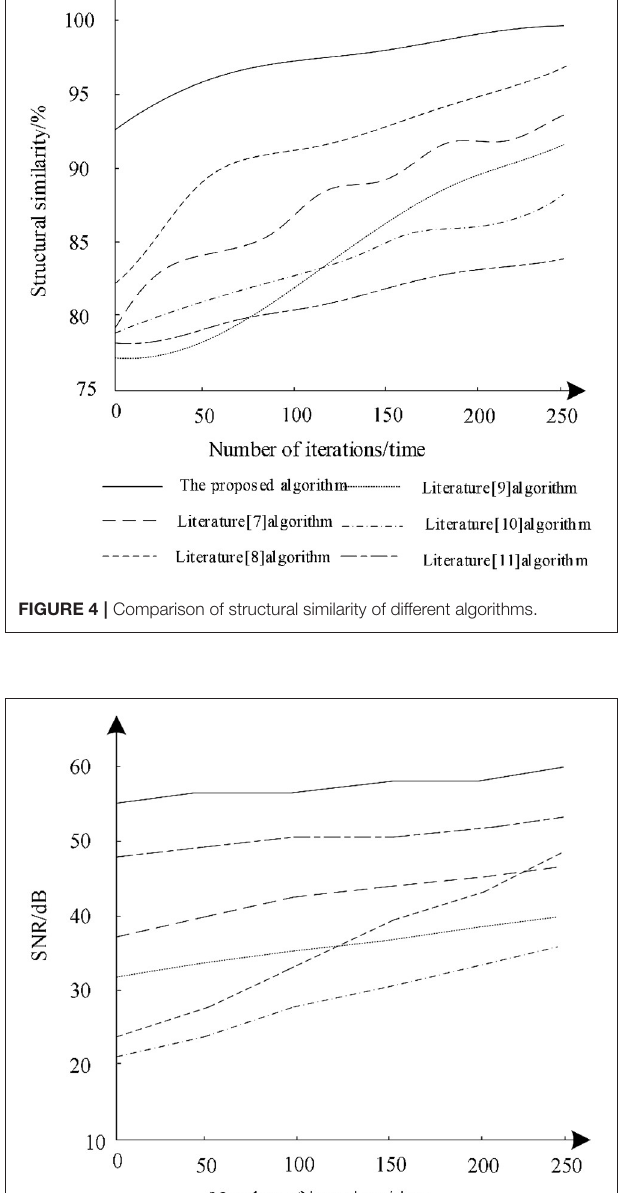
SNR is always maintained between 55 and 60 dB. Therefore, using proposed algorithm for segmentation can effectively reduce image